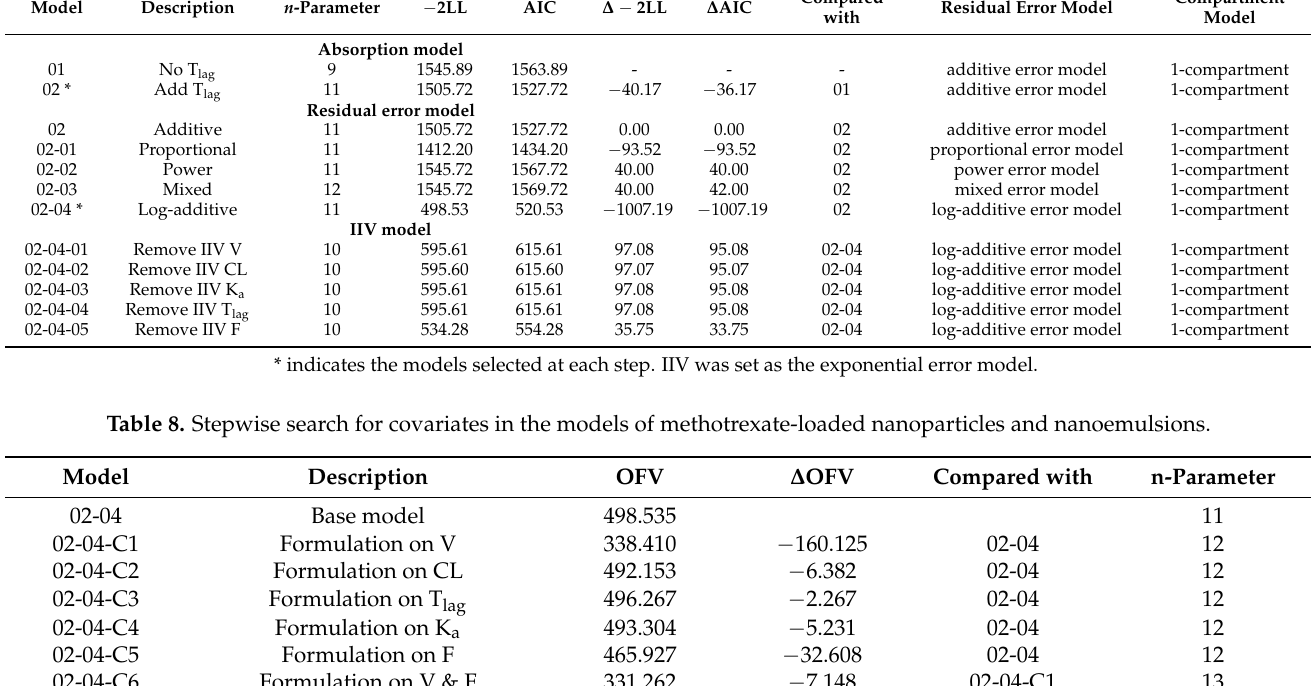
Table 7. Steps used to build the base structural model for methotrexate-loaded nanoparticles and nanoemulsions. Model Description